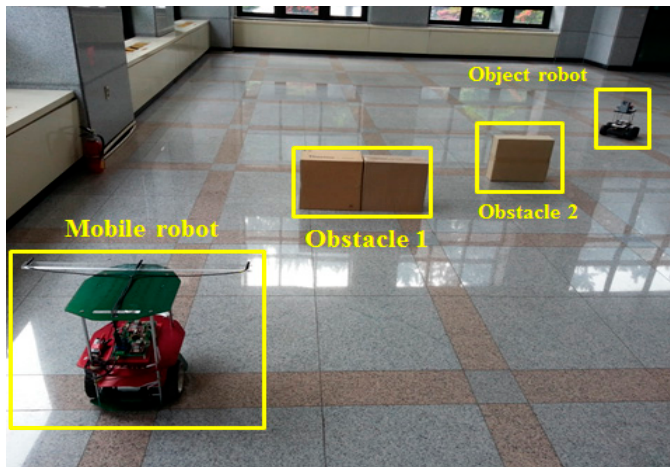
Figure 12. Environment for multiple fixed obstacle avoidance. The sizes of the obstacles were 100 (W) × 30 (H) × 50 (D) mm for Obstacle 1 and 80 (W) × 30 (H) × 50 (D) mm for Obstacle 2.